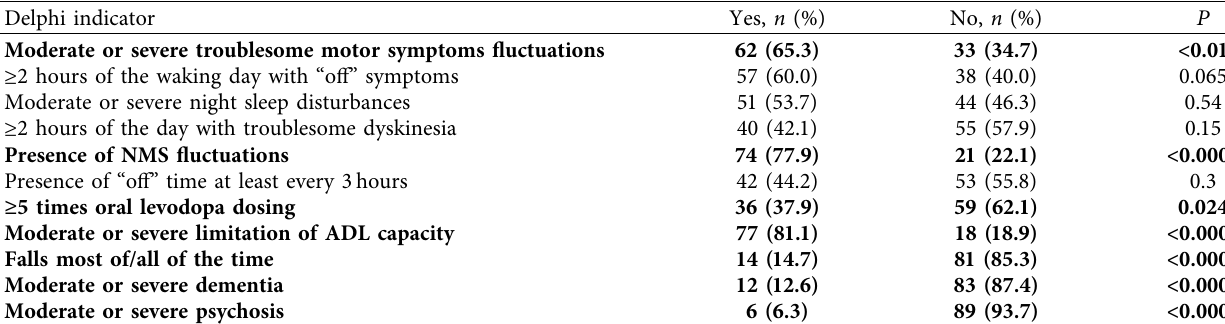
Table 7: Presence of APD indicators in the APD patient